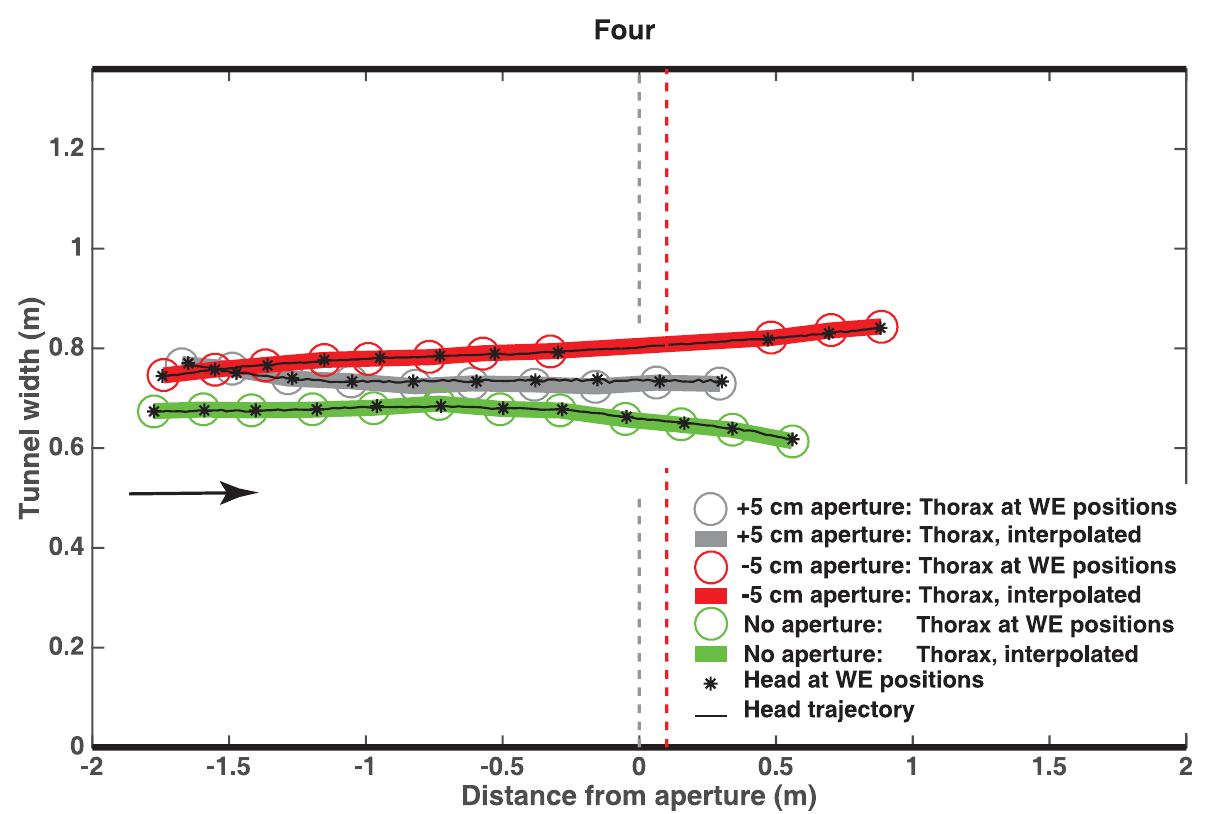
Fig 8. Plan views of 3D trajectories. Trajectories reconstructed for the narrow aperture condition (red), the wide aperture condition (grey) and the no aperture condition (green), for bird Four. In each case, the circles mark the locations of the thorax (defined as the mid-point of the line connecting the extended wing tips) at the time of each wing extension, the thick curves show the thorax trajectory interpolated from the thorax positions at these times, the asterisks mark the locations of the head at the times of the wing extensions, and the thin black curve through the asterisks shows the trajectory of the head, reconstructed from the digitized image co-ordinates of the head in each frame as explained in the text.